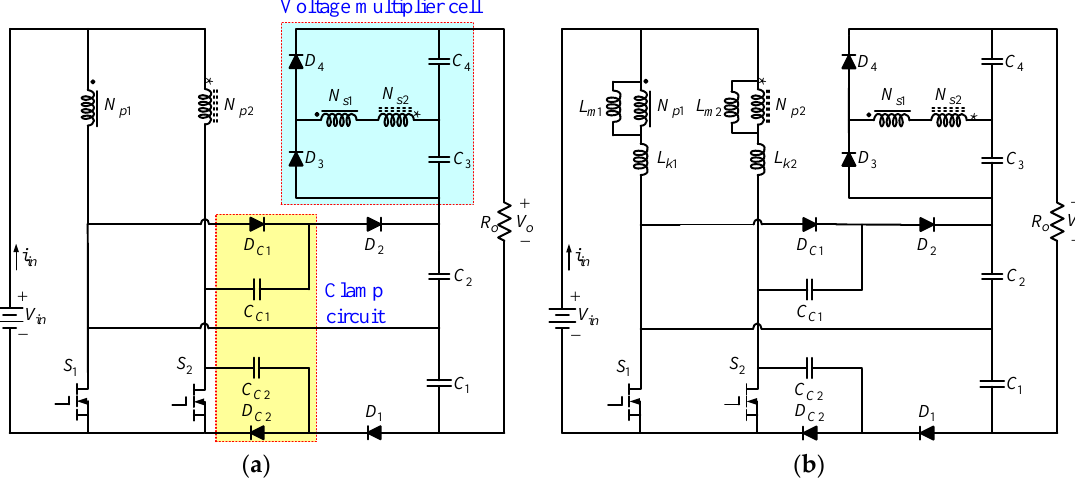
Figure 2. Proposed converter and its equivalent circuit. ( a ) Proposed converter; ( b ) Equivalent circuit.